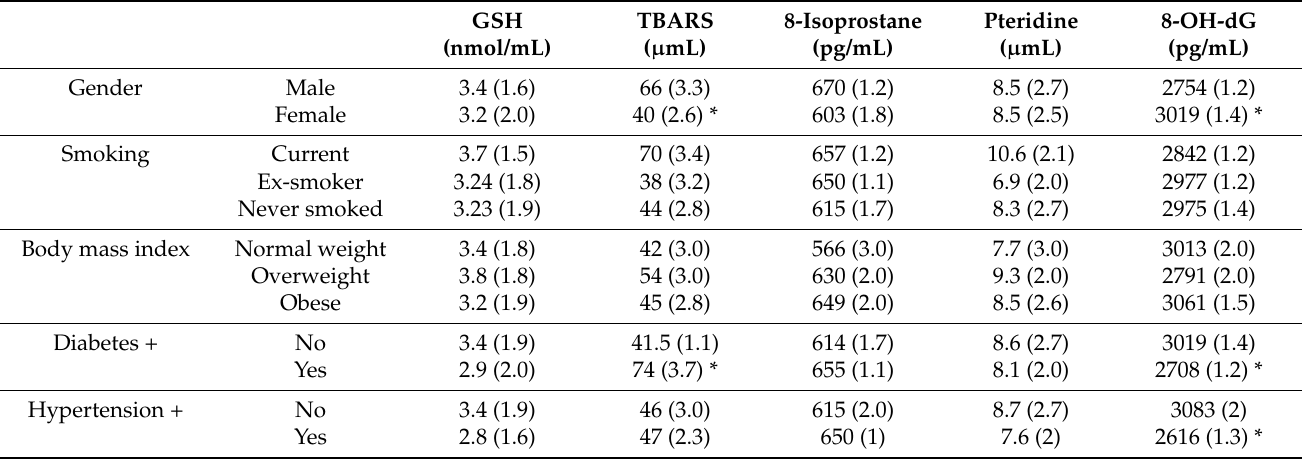
Table 5. Baseline urinary oxidative damage markers levels (geometric mean (SD)) according to baseline clinical characteristics.